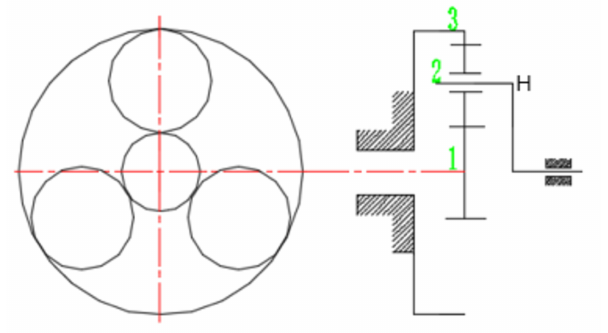
Figure 13. Simple planetary gear